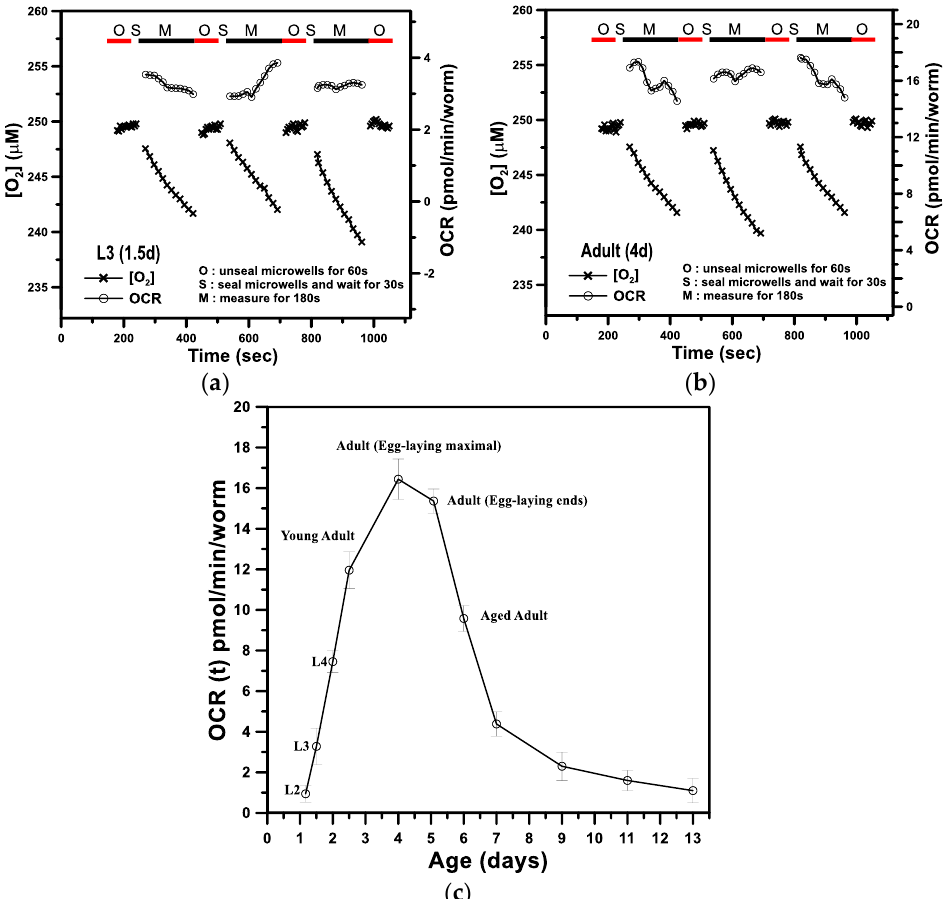
Figure 5. ( a ) The time variation in the aqueous O 2 concentration ([O 2 ], μ M) and OCR ( − d[O 2 ]/dt) for a single C. elegans at ( a ) L3 (1.5 days) and ( b ) adult (4 days). ( c ) The basal OCR of a single C. elegans inside a sealed microwell from the stages of postembryonic development (L2, L3, and L4) through adulthood to aged adult stages. (Mean ± SEM; n = 5).